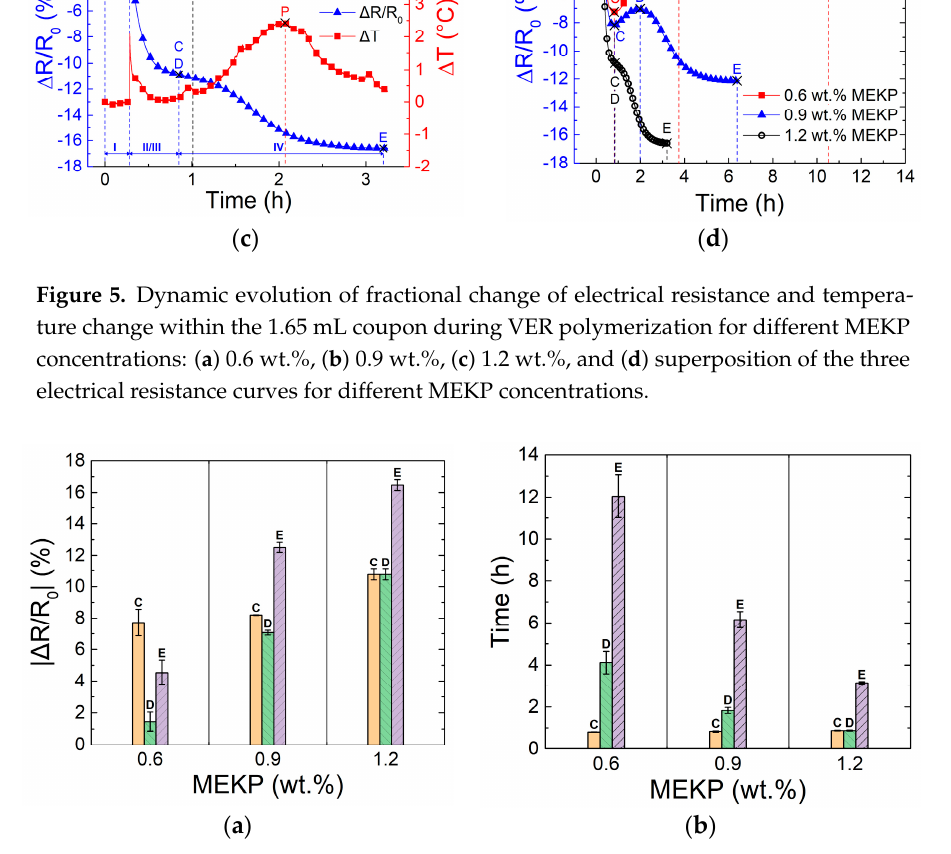
Table 4. Summary of zones that characterize the electrical response of the CNTY upon immersion in VER resin. Zone Description Electrical Resistance Change Dry pre-stressed CNTY within mold. Small decrease in ∆ R/R 0 , attributed to yarn stress relaxation. Liquid VER mixture poured into mold, Transient decrease in ∆ R/R 0 , attributed to free radical electron wetting and wicking into the CNTY. donors competing with initial wicking. Viscosity of the liquid reaction mixture Increase in ∆ R/R 0 , attributed to resin wicking and depletion of free increases to point of gelation. radicals due to monomer